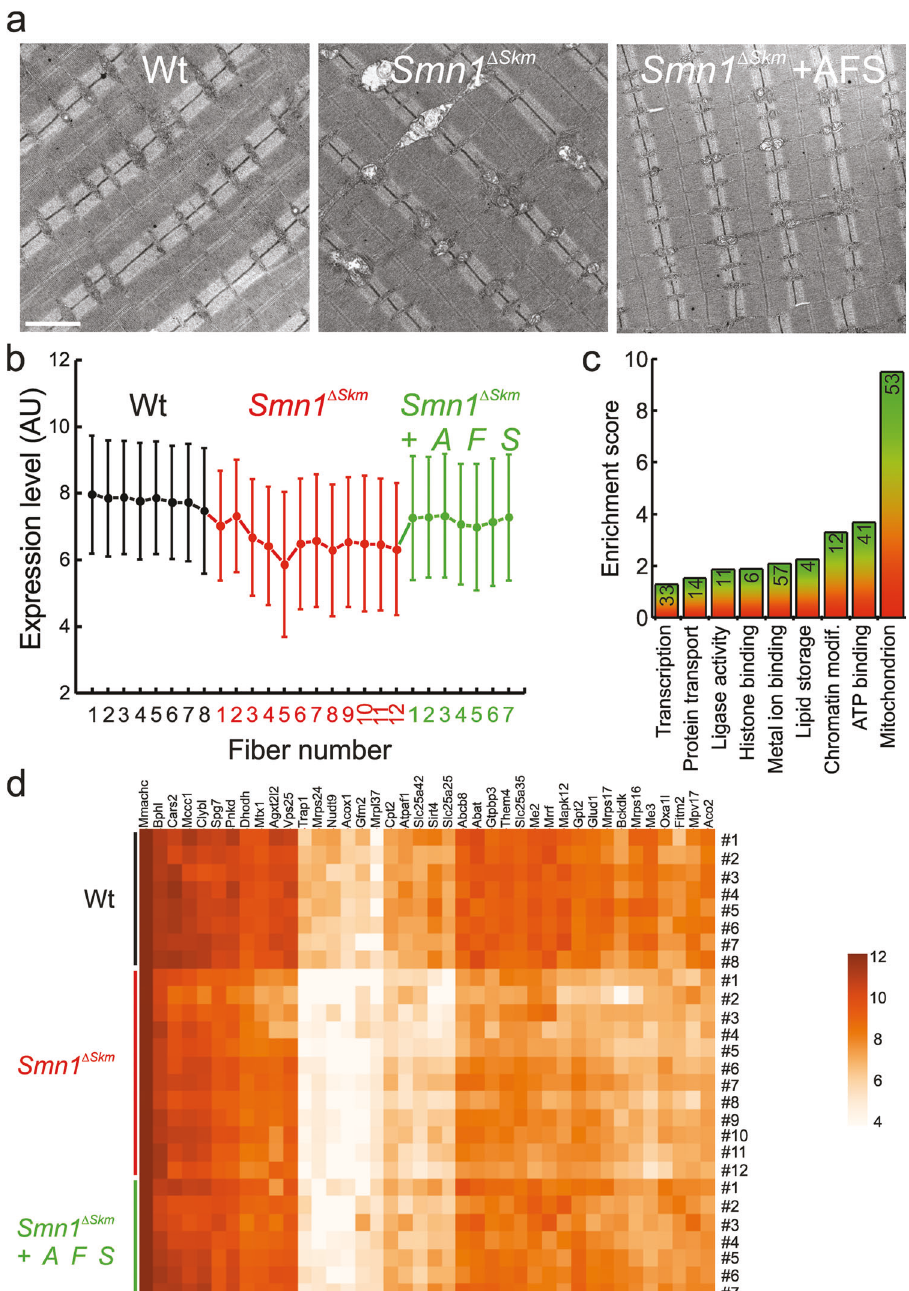
Fig. 8 AFS transplantation in Smn1 Δ Skm mice rescues mitochondrial alterations. a Representative electron micrographs of mitochondria from TA muscles of Wt and untreated or AFS-treated Smn1 Δ Skm mice. Scale bar: 2 μ m. b Expression pattern of genes obtained by Pavlidis Template Matching algorithm that match the template expression pro fi le of high expression in Wt myo fi bers, low in the Smn1 Δ Skm myo fi bers, and high in the Smn1 Δ Skm + AFS myo fi bers (threshold R of 0.7). c Gene ontology analysis of the genes with the expression pro fi le in b . Enrichment score by DAVID was used to rank the annotation groups. The numbers inside bars correspond to the number of genes for each cluster. d Heat-map of the genes with the expression pro fi le pattern in b ) distinguishes the signatures of myo fi bers isolated from tibialis anterior muscles of Wt and untreated or AFS-treated Smn1 Δ Skm